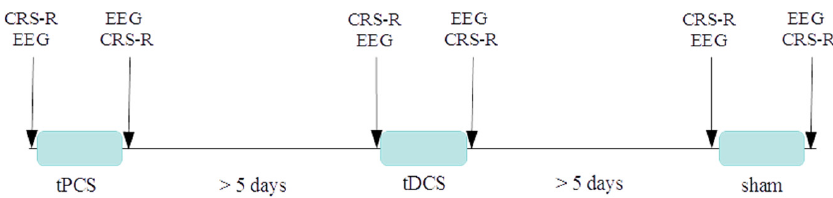
Figure 1. Schematic representation of the protocol. Note that the order of the sessions was randomized for each patient (the order of sessions for each patient can be found in Table 1). During each session both devices were mounted together with the EEG cap, to keep the same montage across sessions and allow blinding. Table 1. Clinical characteristics of the sample and behavioral results. Age is reported in years. Di-